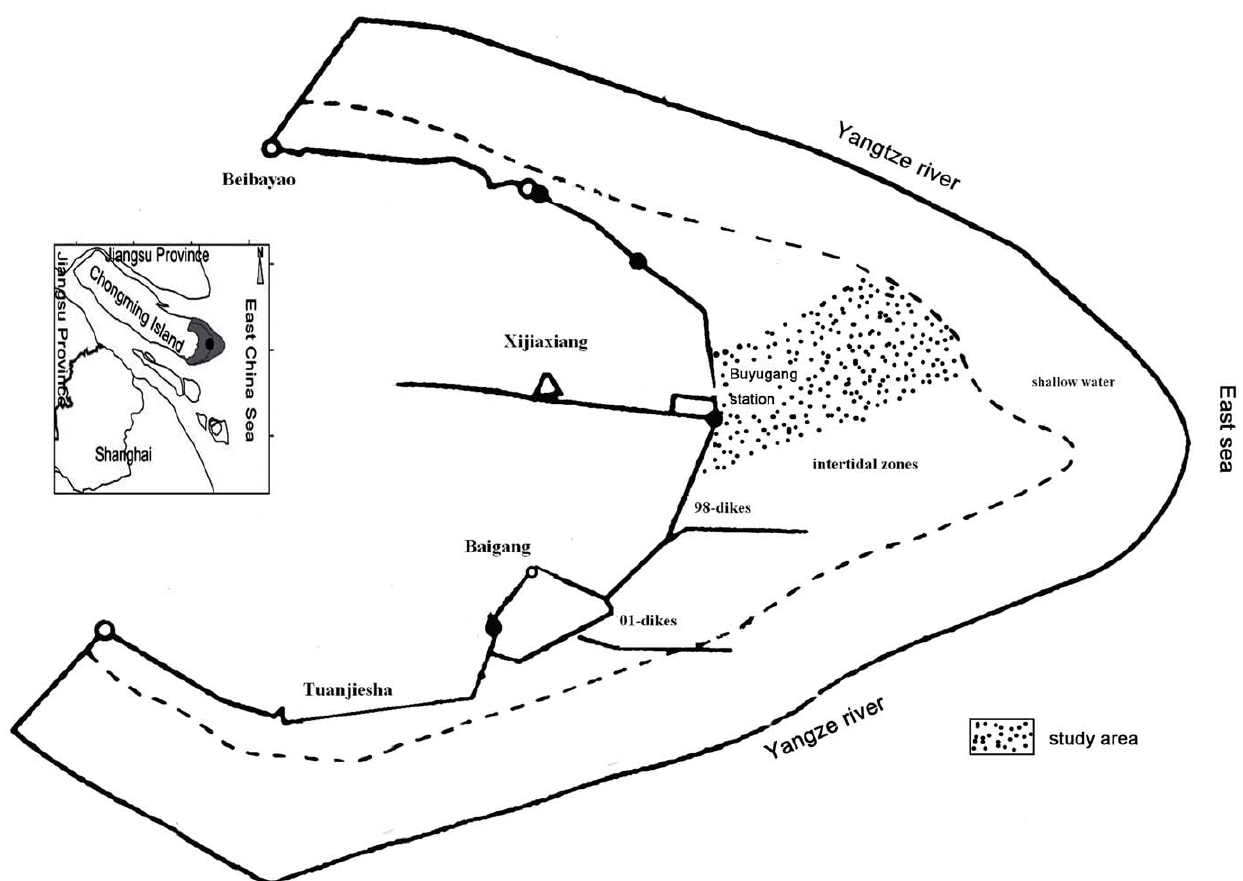
Figure 1. The location of our study area in the Chongming Dongtan Nature Reserve, Shanghai.